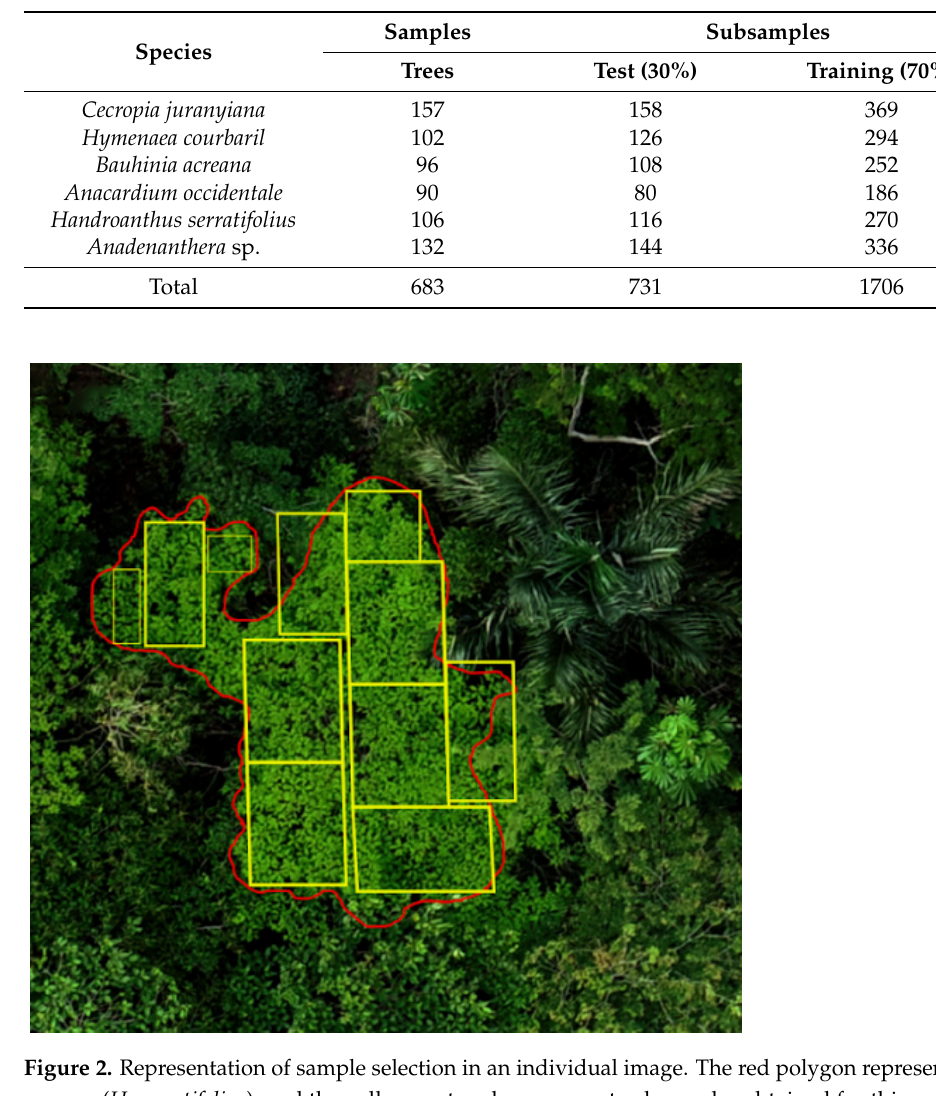
Table 2. Forest species and number of samples for training convolutional networks.